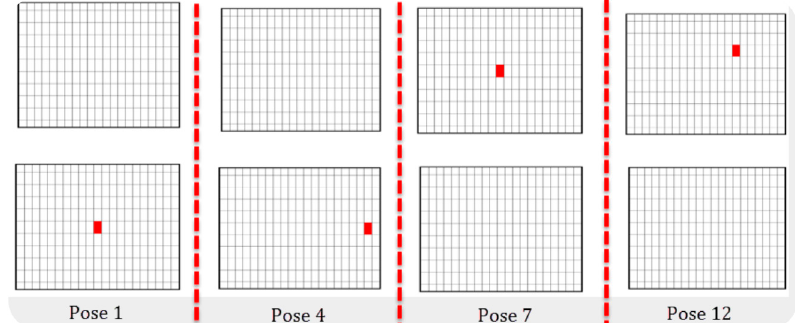
Figure 19. Selected poses for an Action Time of 0.2 s.